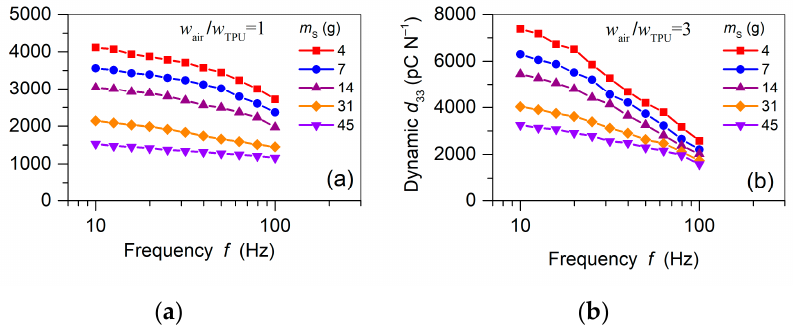
Figure 8. Dynamic piezoelectric 𝑑 (cid:2871)(cid:2871) coefficients versus frequency of the different seismic masses, 𝑚 (cid:2903) , as indicated and a constant acceleration of 3 m s − 2 : ( a ) sample with the (cid:3050) (cid:3159)(cid:3167)(cid:3176) as indicated and a constant acceleration of 3 m s − 2 : ( a ) sample with the w air with the (cid:3050) (cid:3159)(cid:3167)(cid:3176) ratio of 3. Both samples were poled at 25 °C. ratio of 3. Both samples were poled at 25 ◦ C. with the w air w TPU (cid:3050) (cid:3152)(cid:3148)(cid:3153)